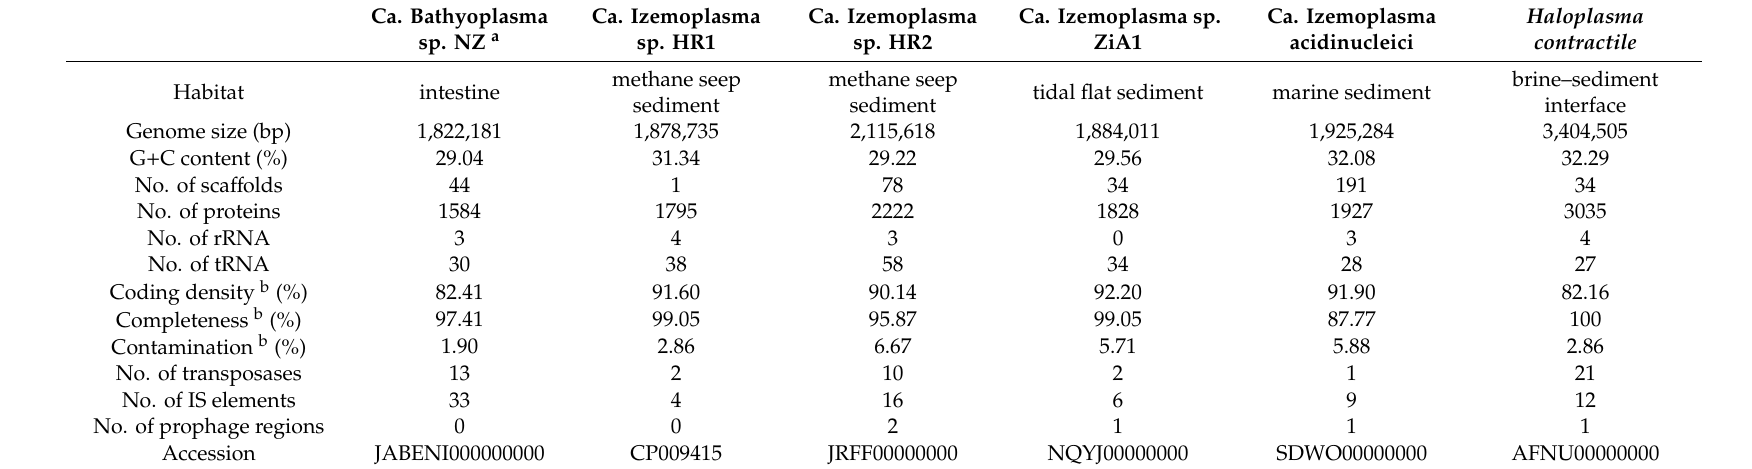
Table 1. General characteristics of